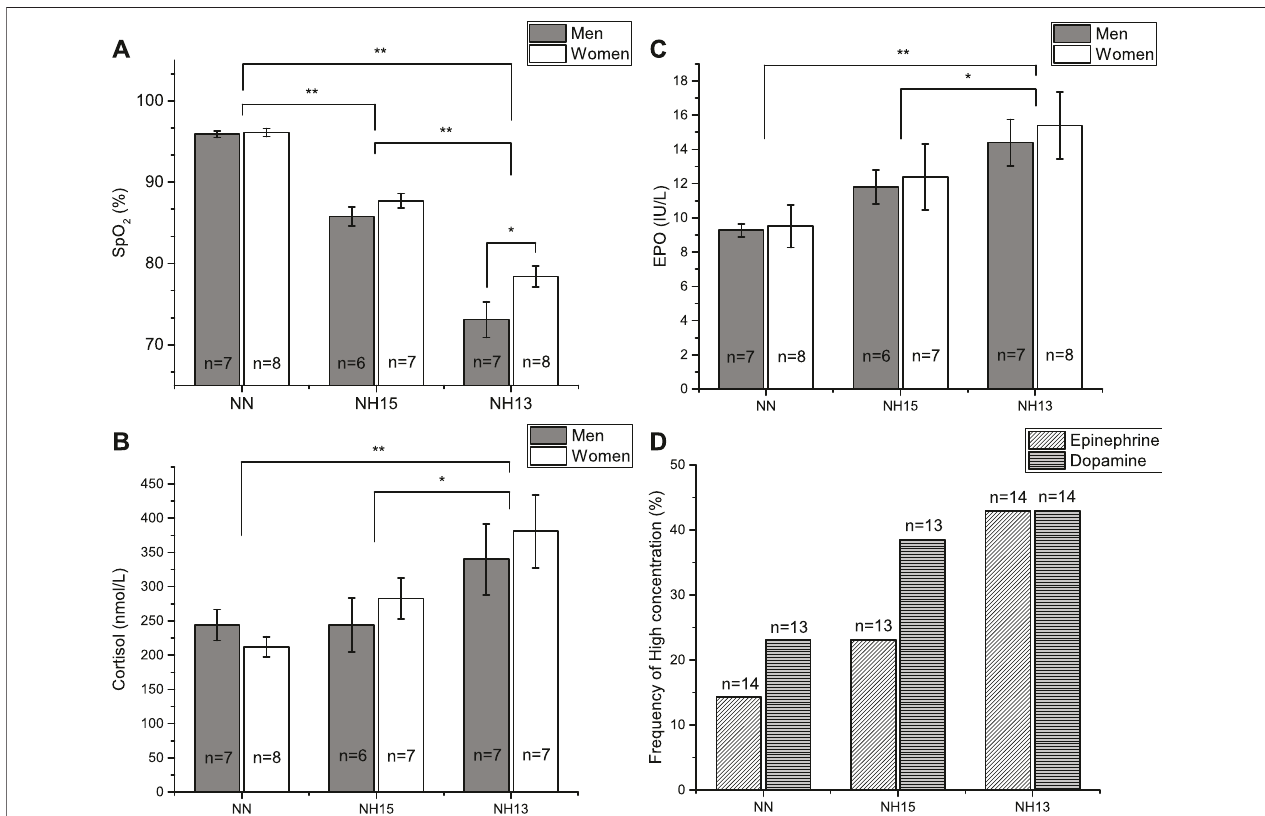
FIGURE 3 | Peripheral oxygen saturation (SpO 2 ) (A) and cortisol (B) and erythropoietin (EPO) (C) concentrations after a 90 min nap under normoxic (NN) and hypoxic conditions (NH15: FiO